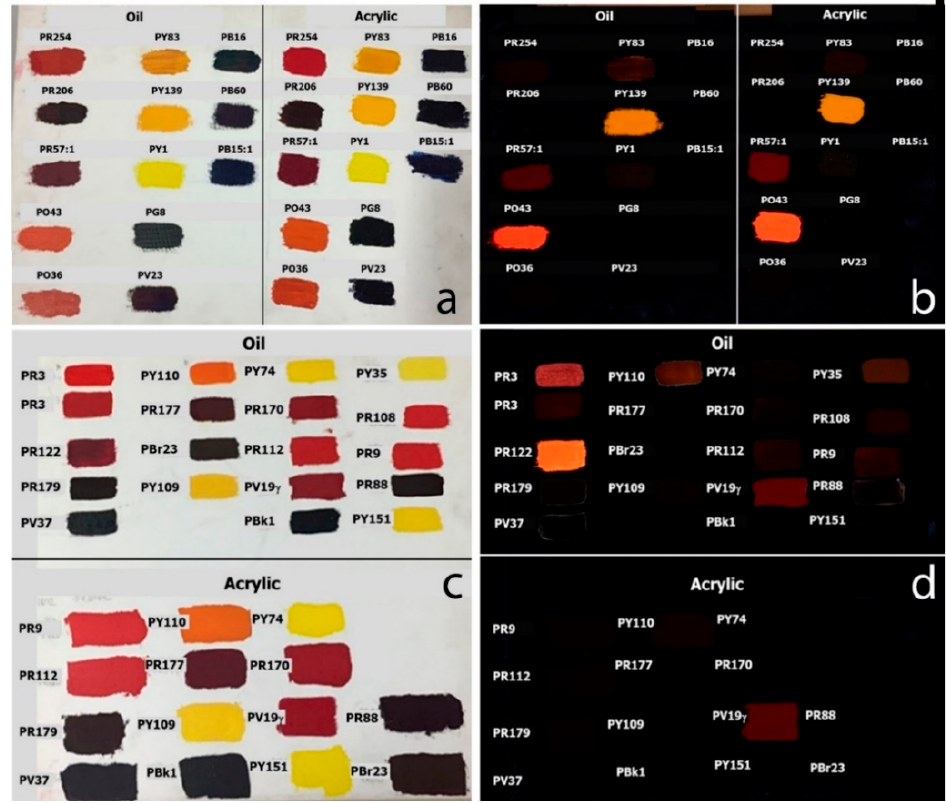
Figure 3. ( a , c ) visible images of a series of mock-up painting samples on canvas of synthetic pigments in oil and acrylic binder; ( b , d ) UVF images. Note: the two mock-ups shown in ( c ) for PR3 contains a different concentration of the pigment, which is present in a higher amount in the mock-up on the second row.